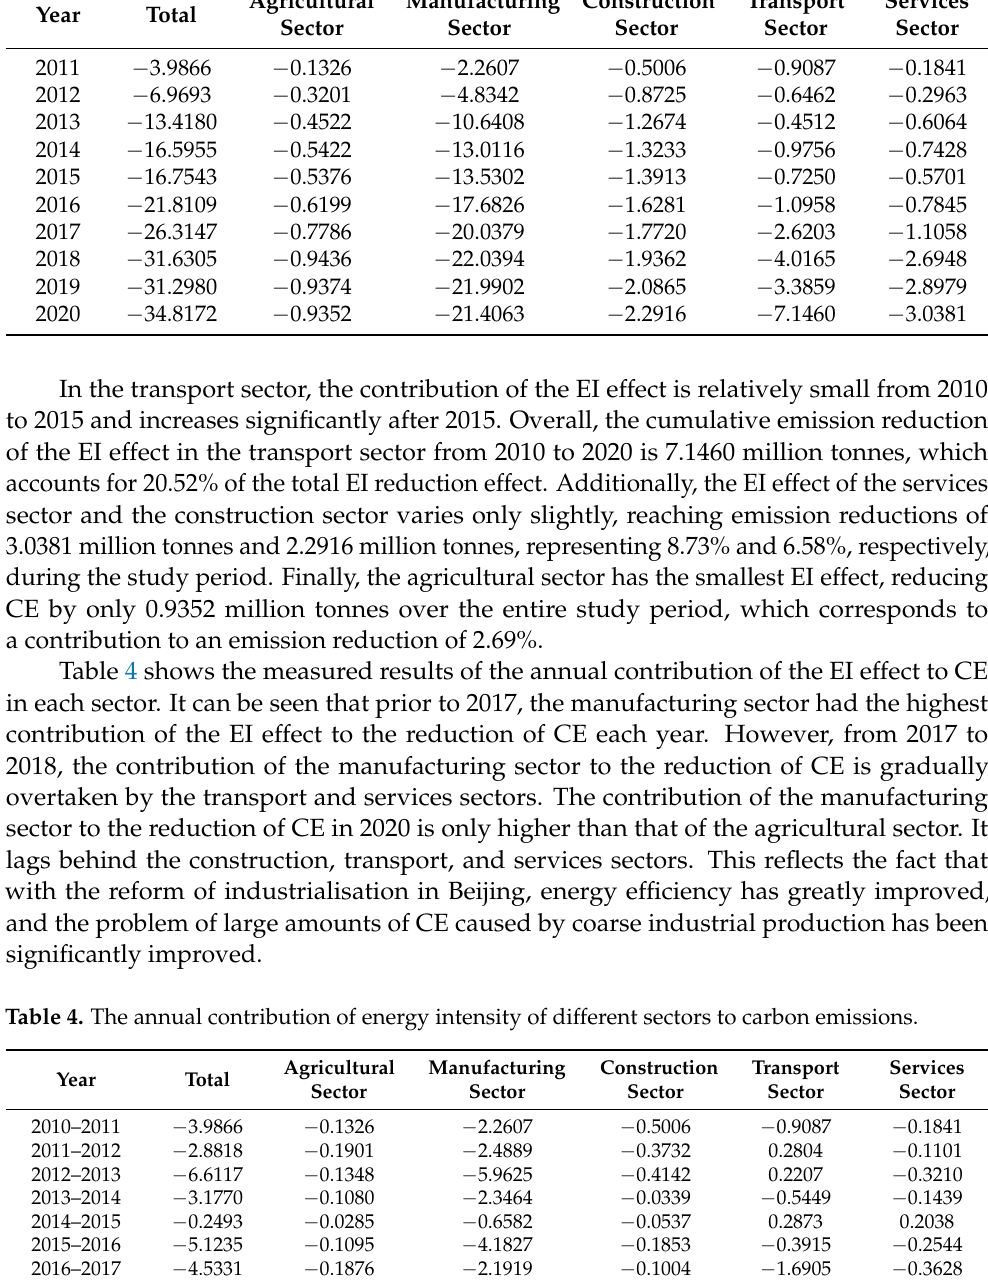
Agricultural Manufacturing Construction Transport Services Sector Sector Sector Sector